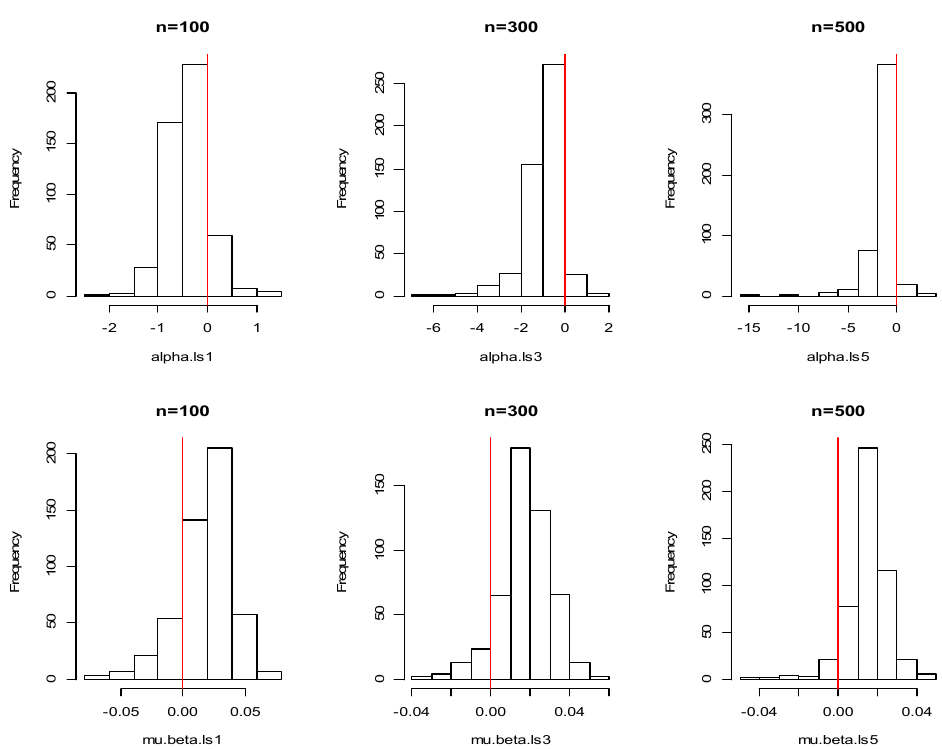
Figure 6. Histogram of estimated parameter α and µ β with the least-squares method in Case 3.